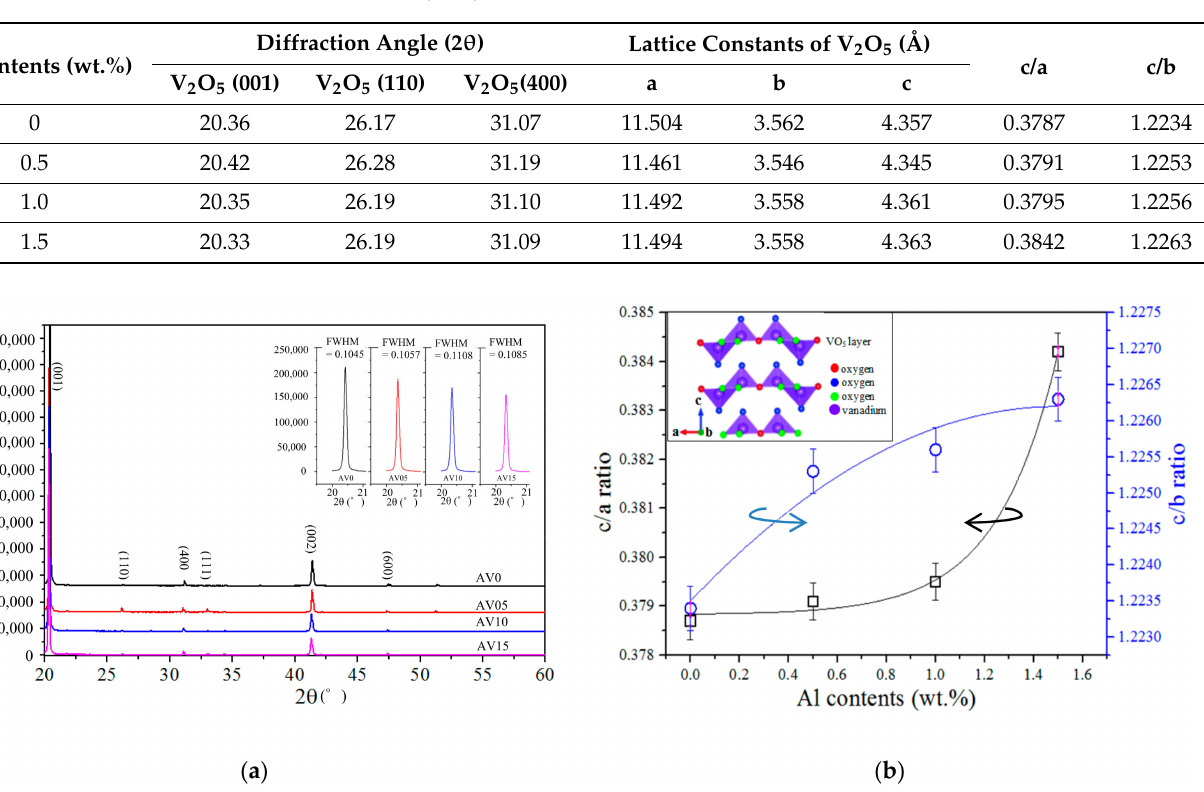
Table 2. Lattice constants, c/a, and c/b of the AV NSs with various Al contents.